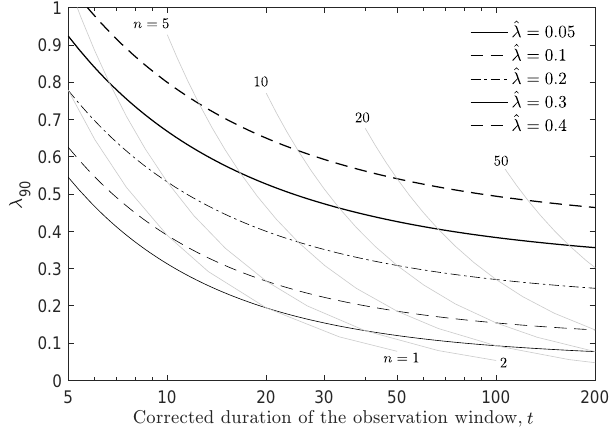
Figure 3. The value of λ 90 as a function of the duration of the ob- servation window, t , or the number of events, n , and the estimated Poisson occurrence parameter ˆ λ .